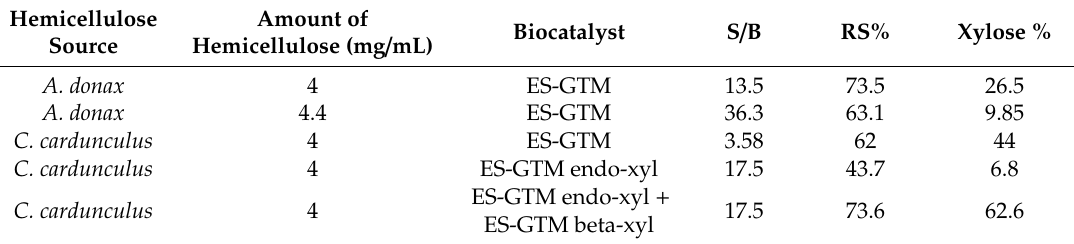
Table 4. Degradative action of P. thermantarcticus xylanolytic enzymatic set on hemicellulose extracts form waste